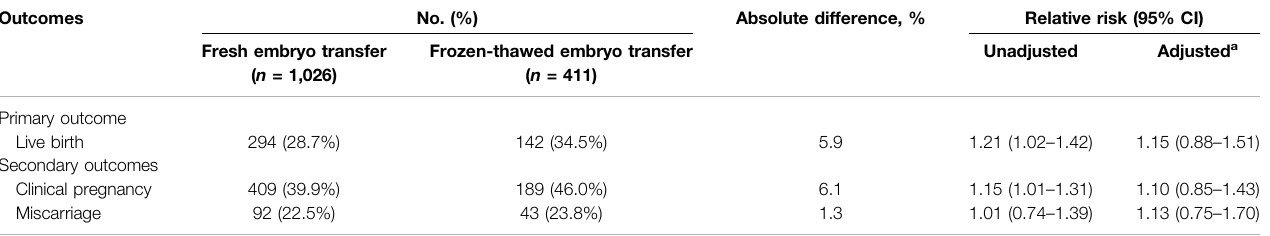
TABLE 2 | Live birth, clinical pregnancy, and miscarriage rates in fresh vs. frozen-thawed embryo transfer cycle.